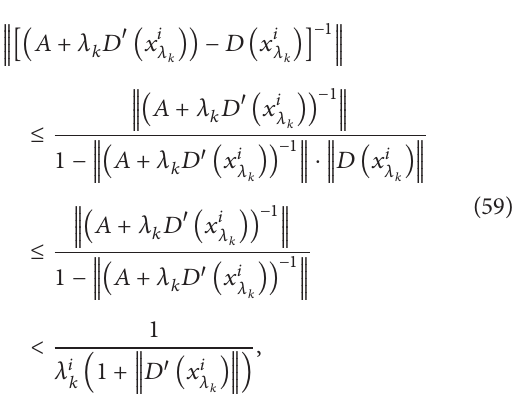
Table 1: The numerical results of Example